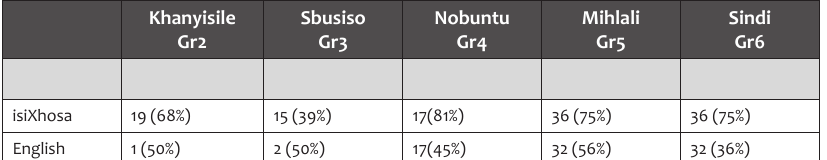
Table 3: Total grammatically acceptable miscues Khanyisile Sbusiso Nobuntu Mihlali Sindi Gr2 Gr3 Gr4 Gr5 Gr6 isiXhosa 19 (68%) 15 (39%) 17(81%) 36 (75%) 36 (75%) English 1 (50%) 2 (50%) 17(45%) 32